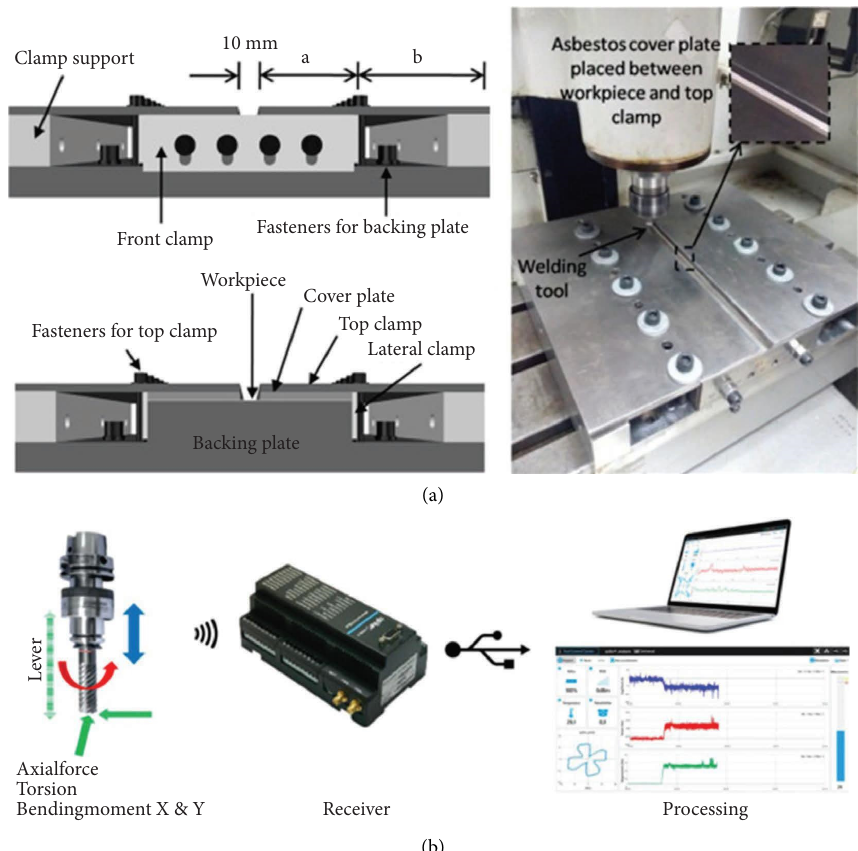
Figure 14: (a) Fixture elements in FSW [141] and (b) tool supplements in the FSW process study